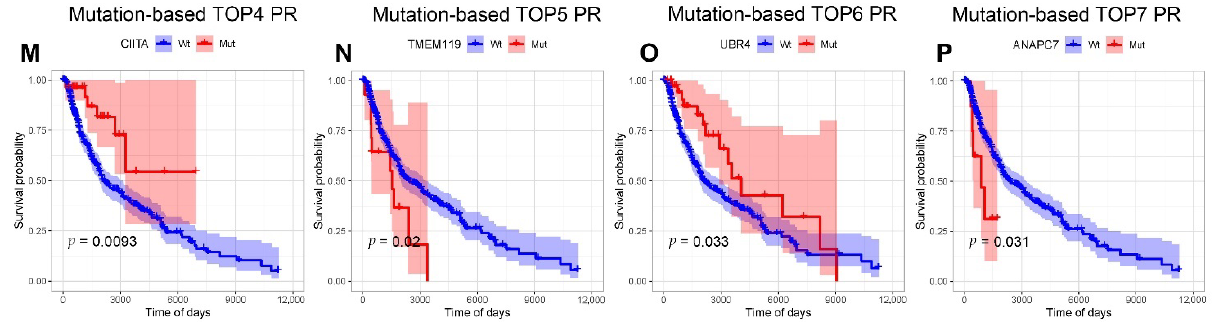
Figure 4. Effect of phagocytosis regulators on tumor survival. ( A – I ) We investigated the effect of phagocytosis regulators’ expression on the survival of skin cutaneous melanoma patients. The expression of 84 genes out of 260 phagocytosis regulators was significantly associated with prognosis. We used the nine with the lowest p values to plot Kaplan-Meier curves, including ACTR3, AXL, BIN2, CD38, CIITA, DOCK2, FCGR1B, FCGR2A, and FCRL3 ( p < 0.0001). ( J – P ) We investigated the effect of mutations in phagocytosis regulators on the survival of skin cutaneous melanoma patients. Among the 260 phagocytosis regulators, 126 genes met the requirement of being mutated in at least five samples, and seven of these genes were significantly associated with prognosis: CADM1, RAC1, PTPRC, CIITA, TMEM119, UBR4 and ANAPC7.